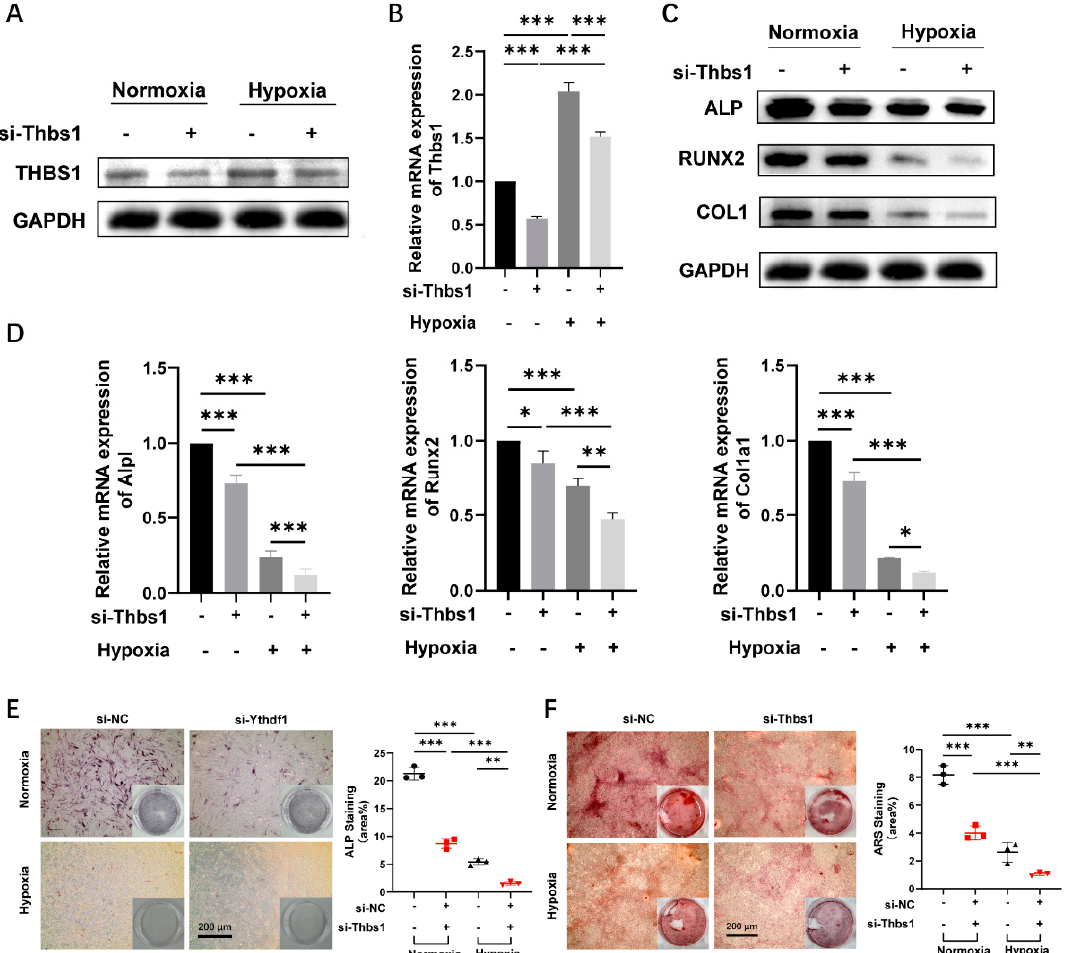
Figure 4. THBS1 promotes MC3T3-E1 osteogenic differentiation under hypoxic conditions. ( A,B ) Protein and mRNA expression of THBS1 in MC3T3-E1 cells transfected with silenced THBS1 were detected after 48 h cultured under hypoxia (1% O 2 ). ( C,D ) Protein and mRNA expression levels of ALP, RUNX2, and COL1 after transfected with si-Thbs1 were detected using qRT-PCR and Western blot in comparison with si-NC under normoxia or hypoxia. ( E,F ) ALP and ARS staining show the inhibitory effect of si-Thbs1 knocking down THBS1 on differentiation of MC3T3-E1 osteoblasts cul- tured in the osteogenic medium under normoxic (21%) and hypoxic (1%) culture. The statistic shows the reduced ALP activity of si-Ythdf1 relative to si-NC with positive staining for calcium nodules, as indicated by the elevated percentage of stained areas. Scale bar, 200 μ m, n = 3. Results are pre- sented as mean ± SD. The p values were calculated by one-way ANOVA followed by Tukey’s test (* p < 0.05, ** p < 0.01, *** p < 0.001, compared with the control group). THBS1, thrombospondin-1; ALP, alkaline phosphatase; RUNX2, runt-related transcription factor 2; COL1, type 1 collagen; ARS, alizarin red staining. 2.6. THBS1 as a Target Gene of YTHDF1 and a Mediator of the Osteogenic Differentiation un- der Hypoxia Overexpression of YTHDF1 was achieved by transfection of Ythdf1-oe plasmid into MC3T3-E1 cells. The transfection efficiency was validated by qRT-PCR and Western blot analysis 48 h after Thbs1-oe transfection (Figure 5A,B). Our previous analysis predicted that YTHDF1-dependent m 6 A methylation of THBS1 mRNAs correlates with osteogenic differentiation of MC3T3-E1 cells. The results verified that overexpressed YTHDF1